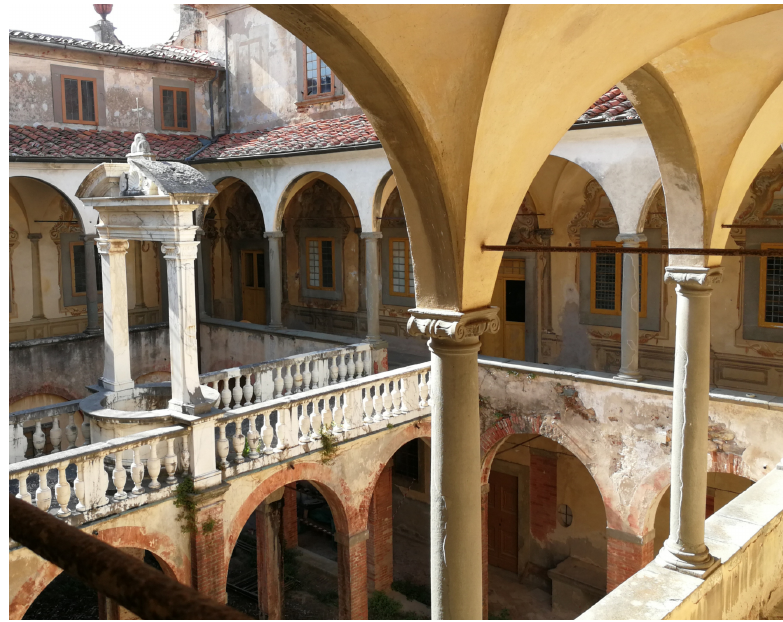
Figure 1. Historic tie-rods: example of tie-rods in one of the internal courtyards in the Certosa di Pisa in Calci, near Pisa,